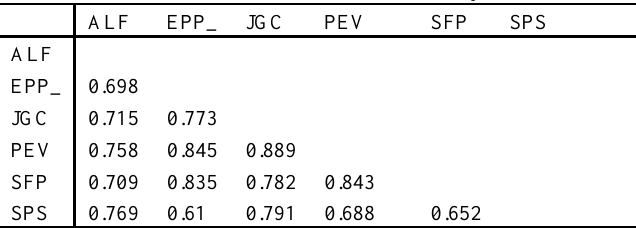
Table 1.2 Discriminant